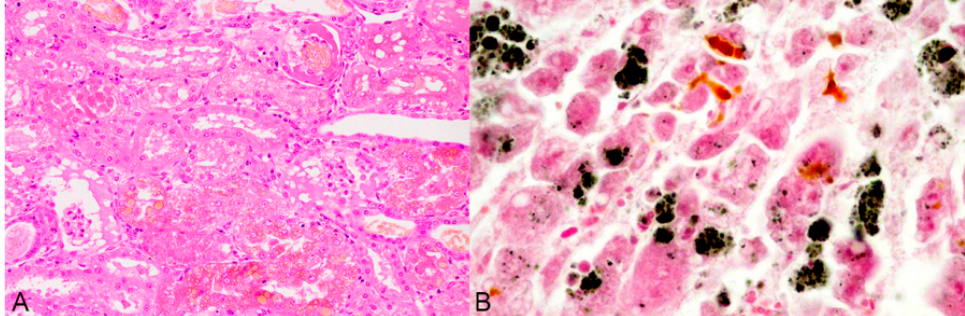
Figure 2. Sheep. Histopathology of chronic copper poisoning. ( A ) Kidney. The renal cortical tubular epithelial cells with vacuolated appearance, degeneration and necrosis. Note the orange-red hyaline material, interpreted as a haem compound, within the vacuoles of some cells. The same material is also found free within the lumen of renal tubuli. Haematoxylin and eosin. Obj. 40×. (B) Liver. Vacuolar degeneration and necrosis of the hepatocytes. Black round spots of different sizes, indicating copper granules, are found dispersed or condensed into the cytoplasm of hepatic cells. Note the dark yellow pigment within the bile canaliculi. Rubeanic acid stain. Obj. 40×. Image 2B courtesy of Professor V. Pérez, León University, Spain.